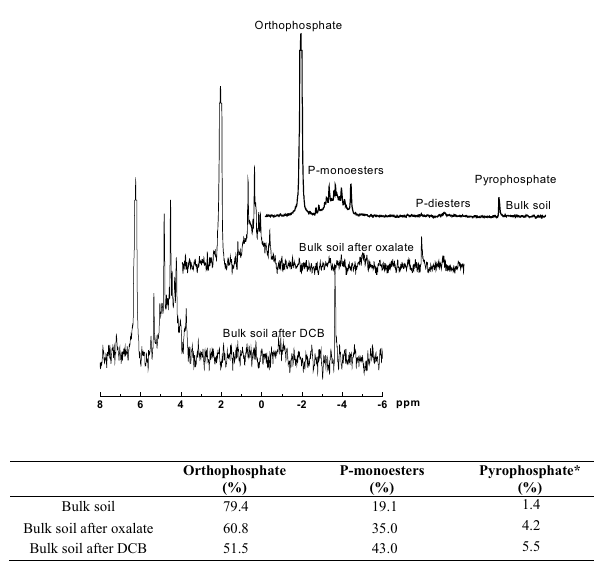
Figure 2. Solution phosphorus-31 nuclear magnetic resonance spectra of NaOH–Na 2 EDTA extracts of bulk soil without and with oxalate and dithionite (DCB) pre-treatments (all subfigures have been reduced by the same factors). The associated table only shows the relative mass distribution (%) of orthophosphate, P-monoesters and pyrophosphate in NaOH–Na 2 EDTA extracts of bulk soil with- out and with oxalate and DCB